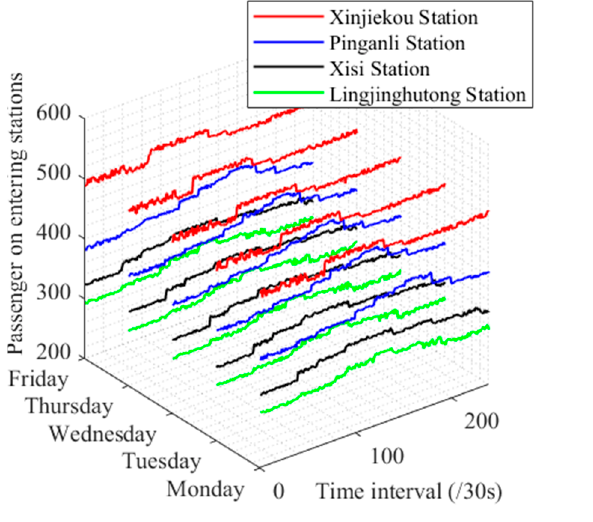
Figure 5. Distribution of passenger flow changes under different days: ( a ) passenger flow entering stations on different days; ( b ) passenger flow leaving stations on different days.